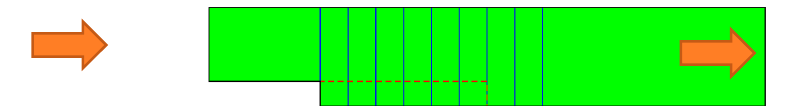
Figure 4. Two-dimensional model of the backwards step with the lines used to compare the computed profiles with experimental profiles ( − ) and the area where the recirculation zone was plotted (--).